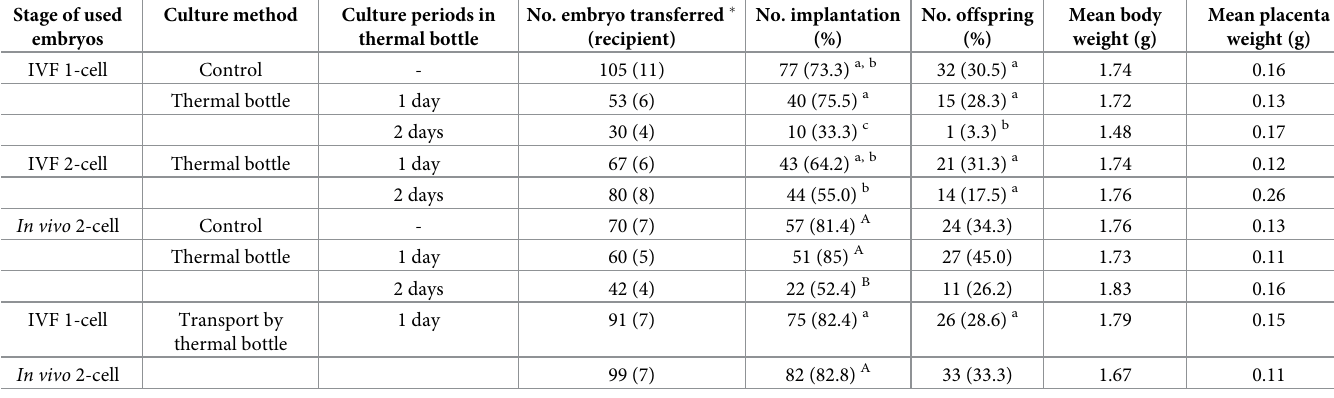
Table 6. Birth of offspring using a sealed tube with OptC medium and cultured in a thermal bottle. Stage of used